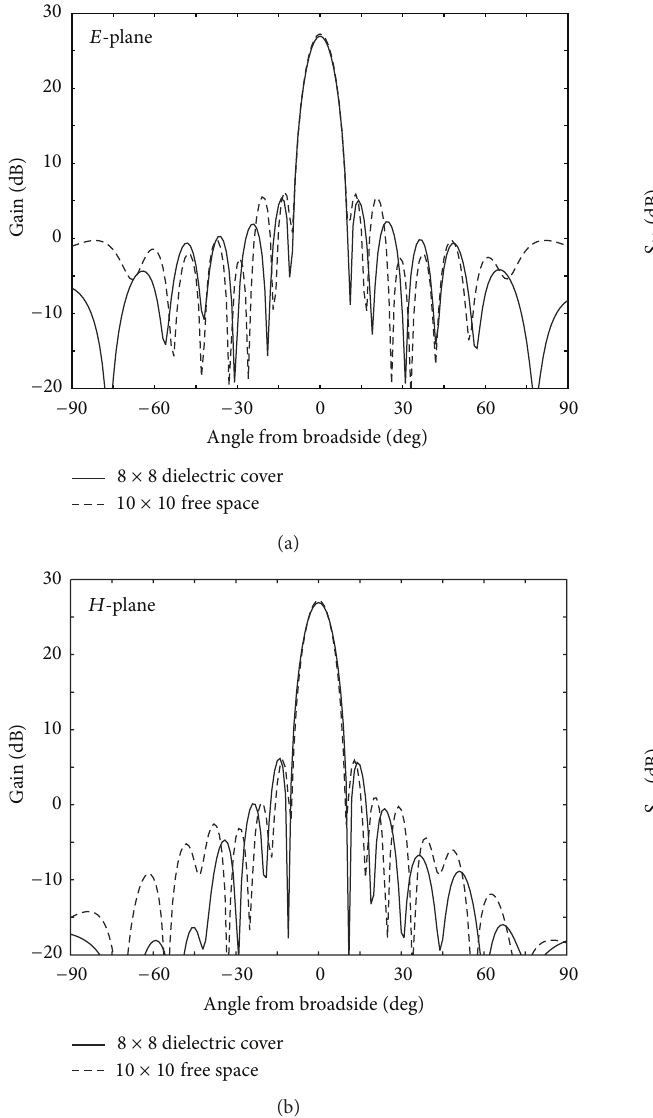
Figure 6: Frequency response (HFSS) of the designed